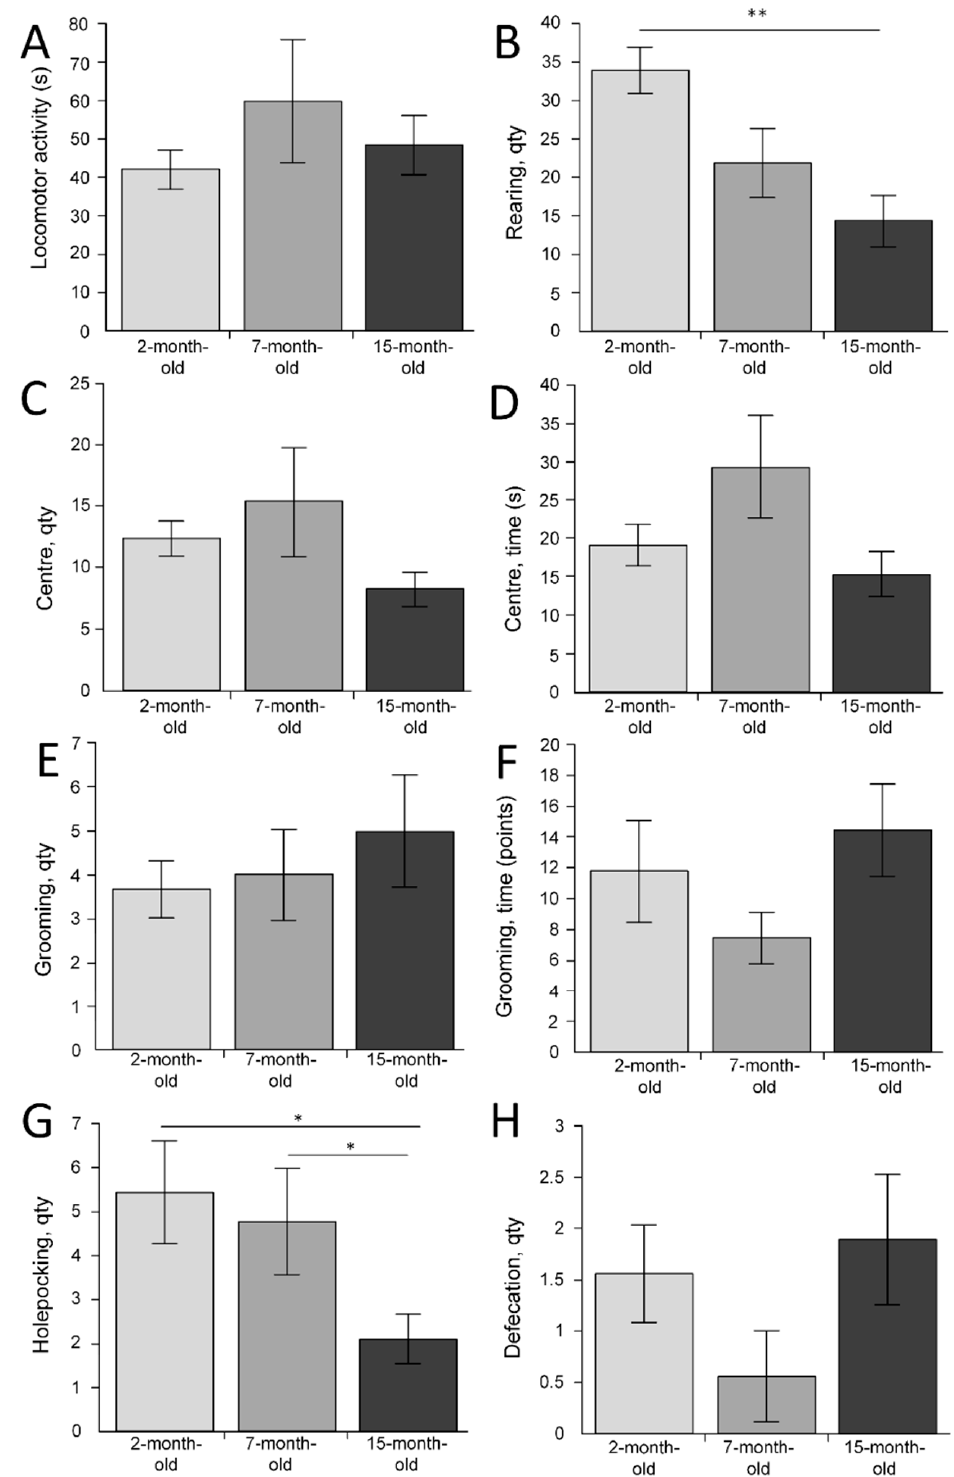
Figure 4. The results of the open field test for the three age groups. ( A ) Locomotor activity (s); ( B ) rearing acts (quantity); ( C ) entering to the center (quantity); ( D ) time in the center area (s); ( E ) grooming acts (quantity); ( F ) grooming time (s); ( G ) hole-poking acts (quantity); ( H ) defecation acts (quantity). * p < 0.05; ** p < 0.01 differences between age groups were statistically significant according to the Mann–Whitney test. The 2-month-old mice (n = 9), 7-month-old mice (n = 9), 15-month-old mice (n =